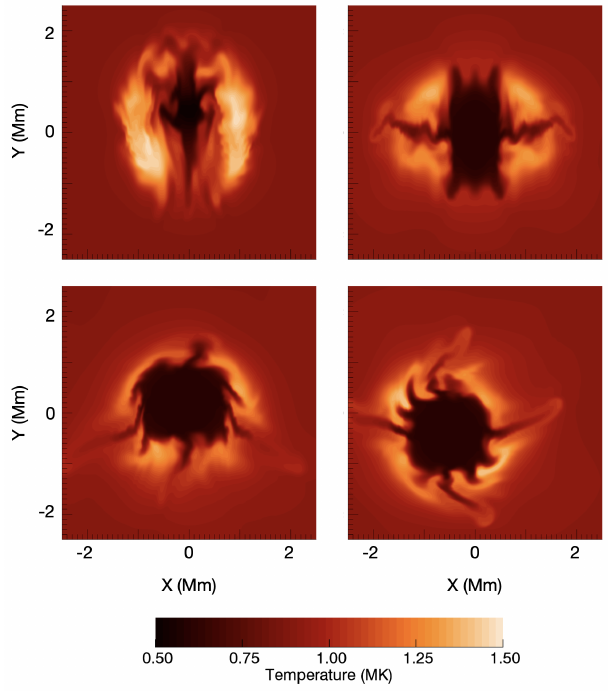
Figure 5. Temperature profile at t = 3100 s for the ResUni ( upper, left ), BbUni ( upper, right ), ResMulti ( lower, left ), and BbMulti ( lower, right ) simulations. Horizontal cuts through the apex of the loops ( z = 100 Mm) are shown. See text for